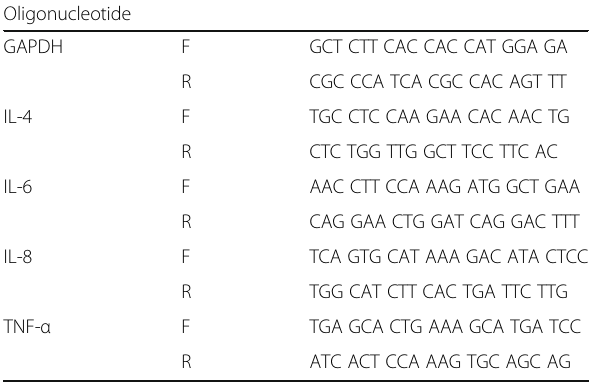
Table 2 Reverse-Transcriptase PCR primer sequences of oligonucleotide Oligonucleotide